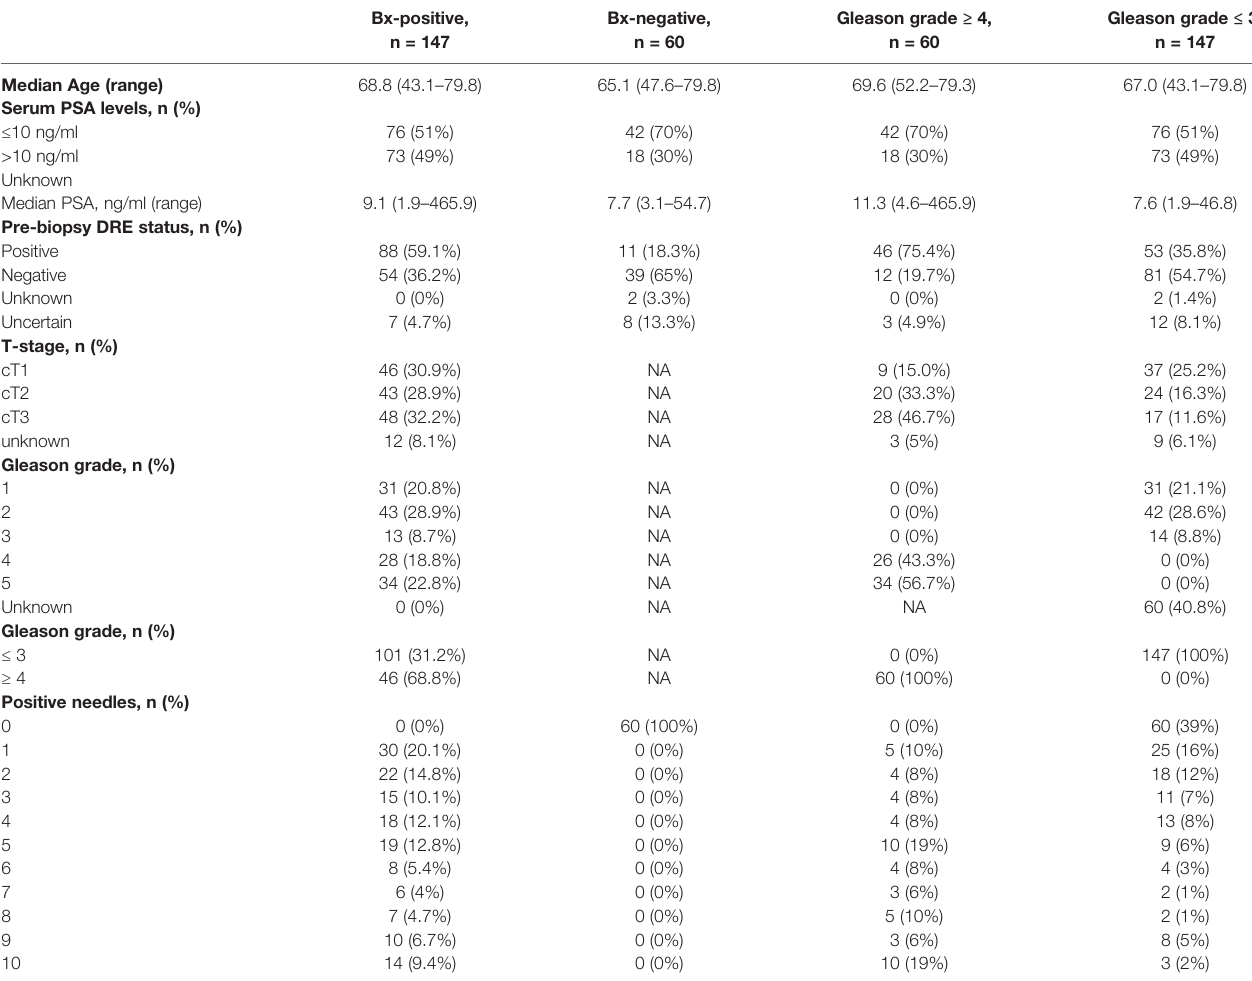
TABLE 1 | Patient characteristics showing median age, serum PSA, pre-biopsy digital rectal examination (DRE) status, clinical stage, Gleason grade from biopsy and number of positive needles strati fi ed as biopsy-positive (Bx-positive) versus Bx-negative groups or as Gleason grade ≥ 4 versus Gleason grade ≤